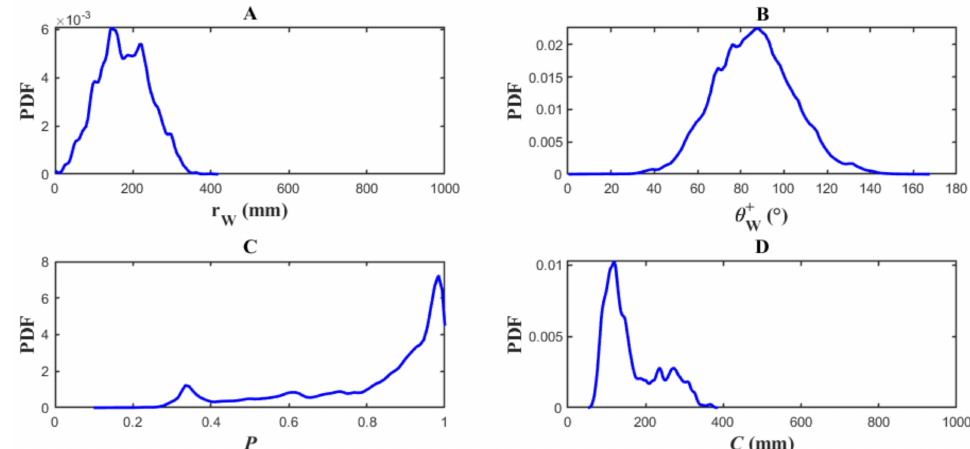
Figure 11. The probability density function (PDF) of the three Cuboid robots collective motion experiment with the DNN model and LVPS strategy. ( A ) PDF of the distance from the wall to each robot r w ; ( B ) PDF of the absolute value of relative angle to the wall of each robot θ + ; ( C ) PDF of the robot group polarization P ; ( D ) PDF of the group cohesion C W